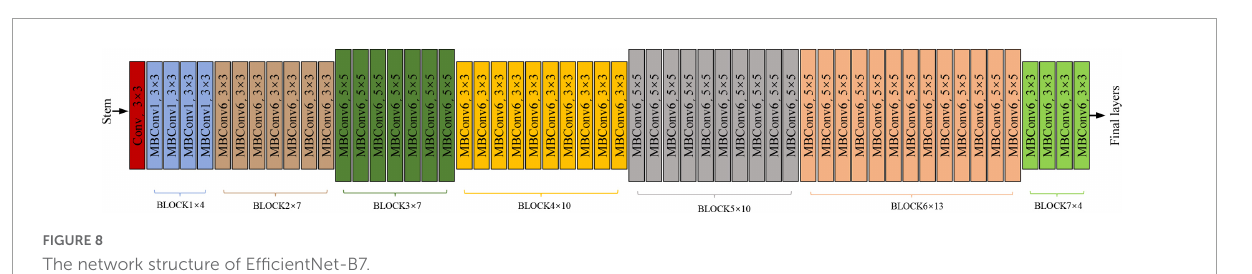
FIGURE7 Mobile inverted bottleneck convolution.